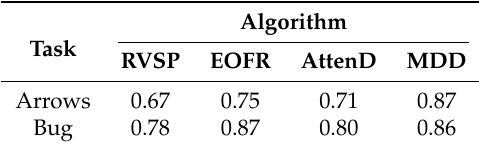
Table 5. AUC comparisons by algorithm across